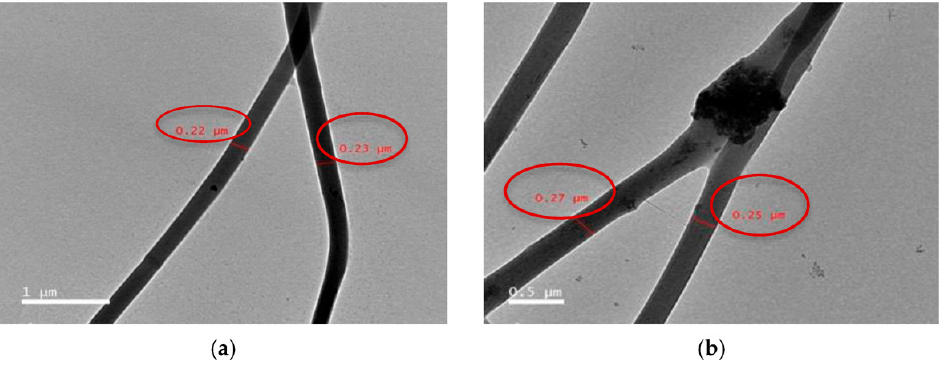
Figure 2. Transmission electron microscopy of prepared fibers: sample CA13 at image scale 1 µm ( a ), HAP particles dispersed inside the sample CA13 at image scale 0.5 µm ( b ) [77]. HAP particles dispersed inside the sample CA13 at image scale 0.5 µ m ( b )